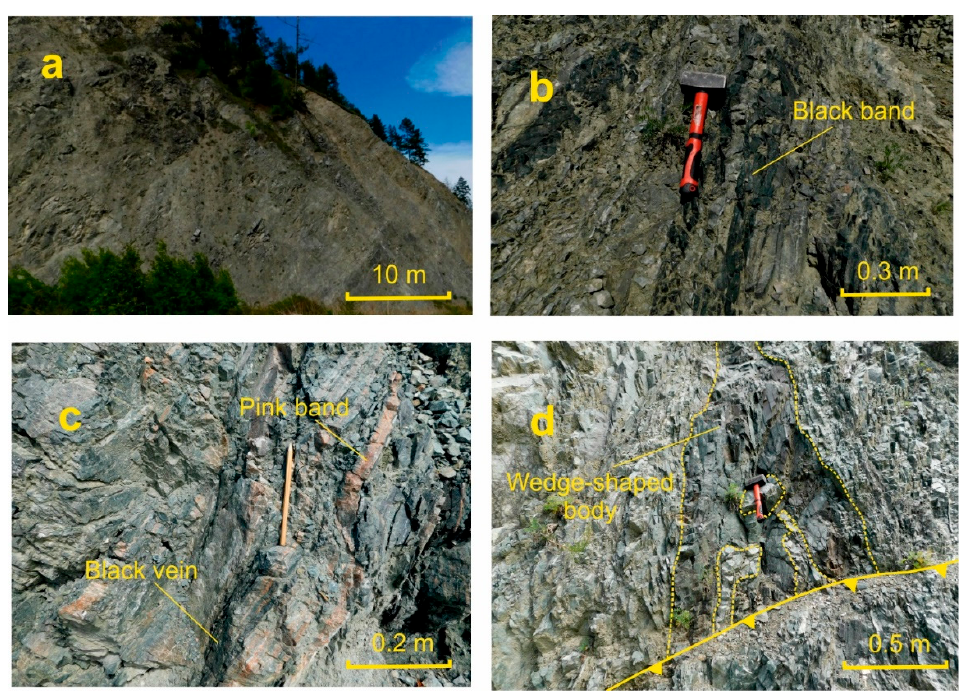
Figure 2. General view of the MSF outcrop located 1 km west of the Kultuk village ( a ), black band series (basic composition) ( b ), pink band series (silicic composition), cut by black veins ( c ), and a wedge-shaped body of dark-gray rock (intermediate composition) ( d ). In photograph a, dark saturated by injected rocks stripes dip under a slope of a quarry. In photograph d, a wedge-shaped fragment is cut at the base by a horizontal rupture.